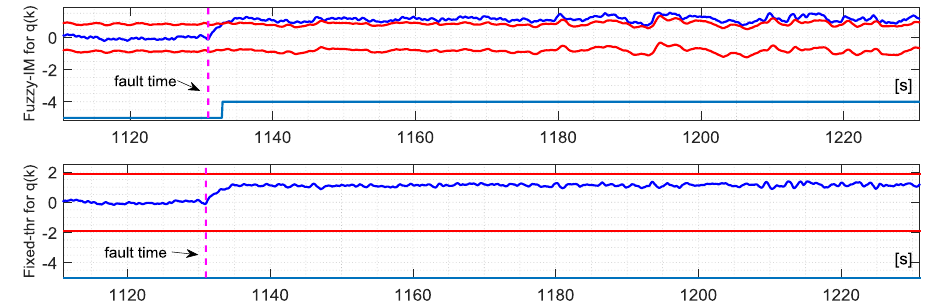
Table 6. Mean FD performance in the four validation flights for the sensor p (k).